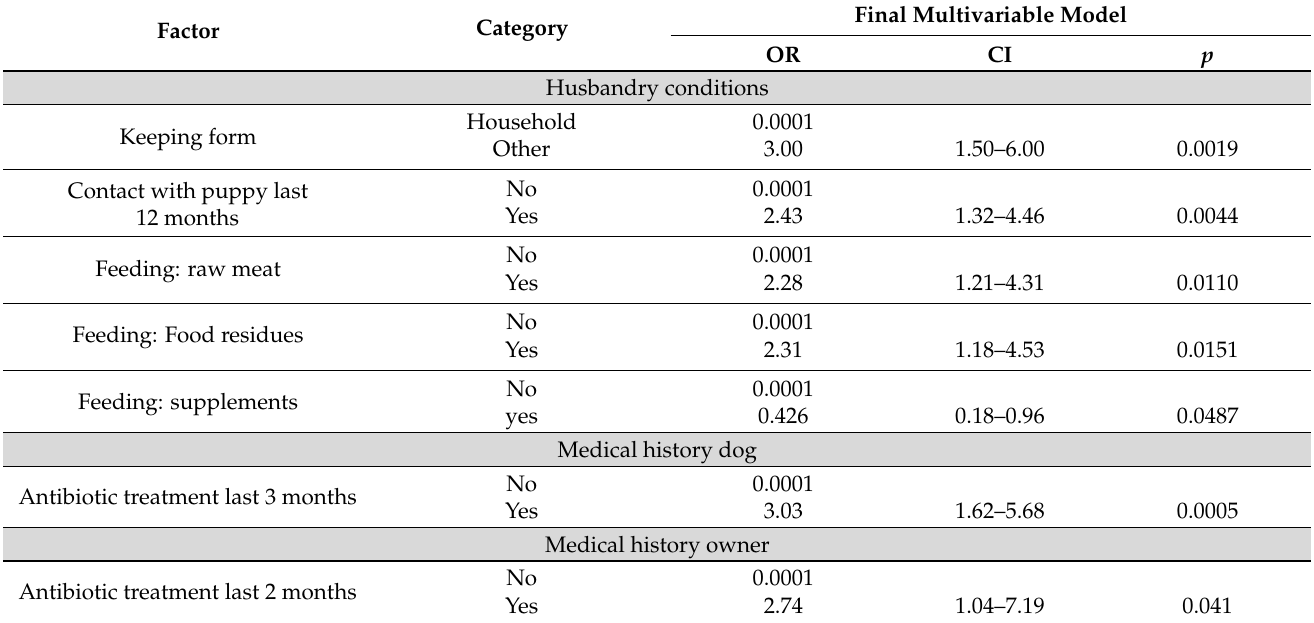
Table 2. Questionnaire variables and association with ESBL- E. coli carriage in the final multivariable model. Factor